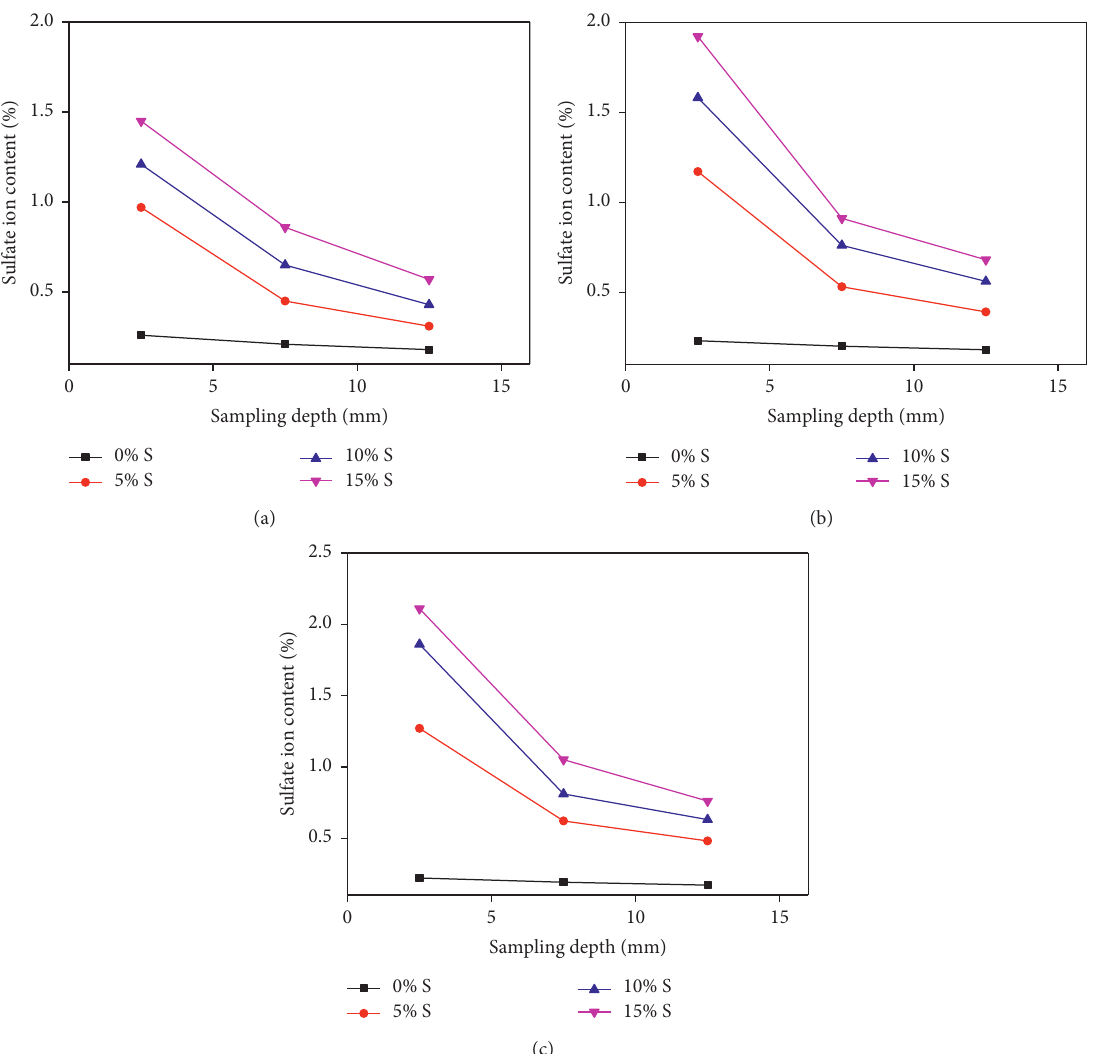
Figure 7: Sulfate ion contents at different depths of CGFB samples immersed in 0–15% sodium sulfate solutions at the (a) third, (b) ninth, and (c) fifteenth drying-wetting